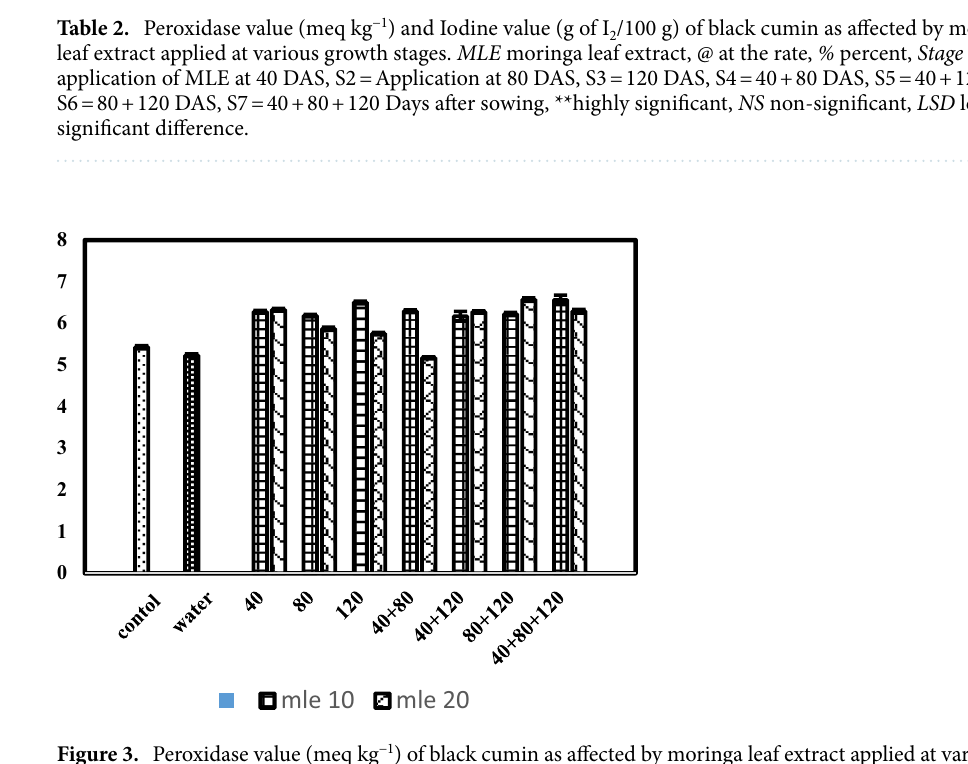
Figure 3. Peroxidase value (meq kg −1 ) of black cumin as affected by moringa leaf extract applied at various growth